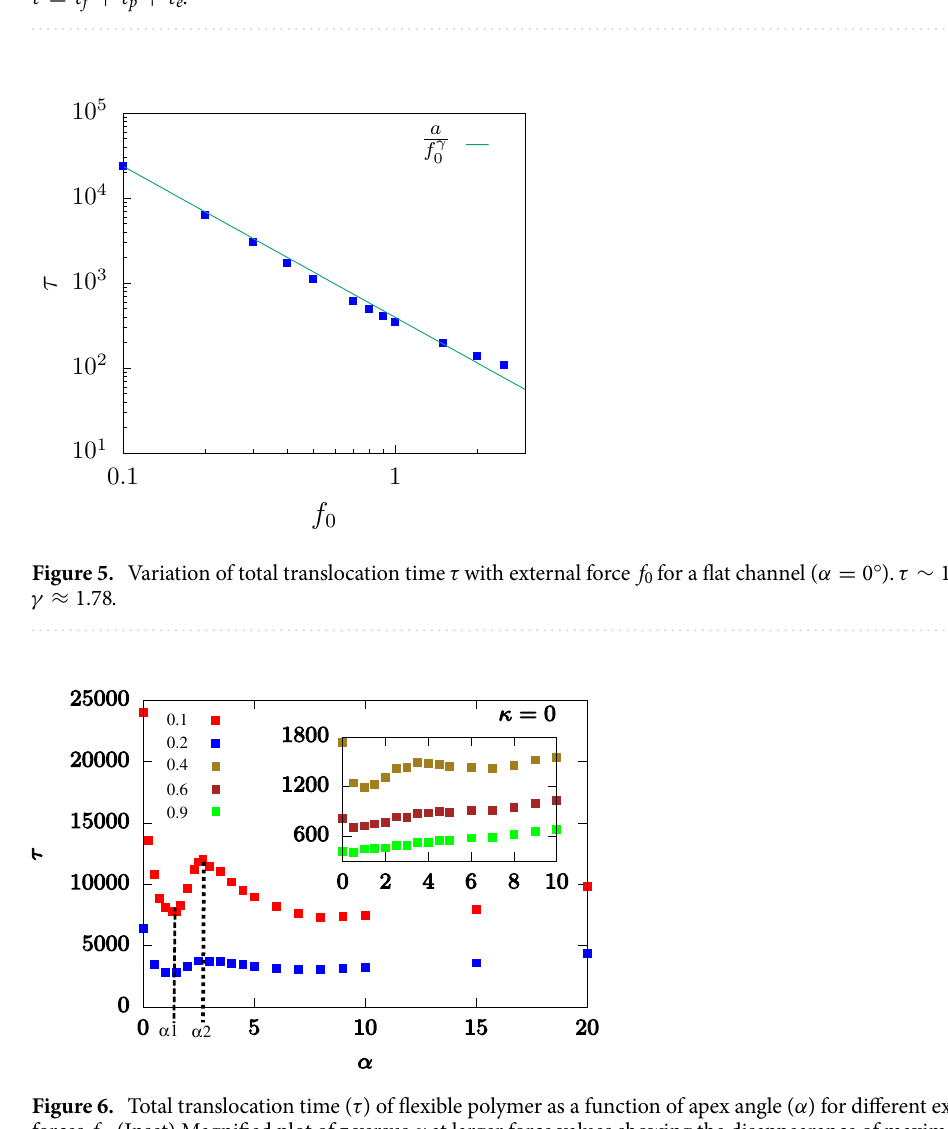
Figure 4. Variation of different time components ( τ s ) with external force f 0 for a flat channel ( α = 0 ◦ ). Here, τ = τ